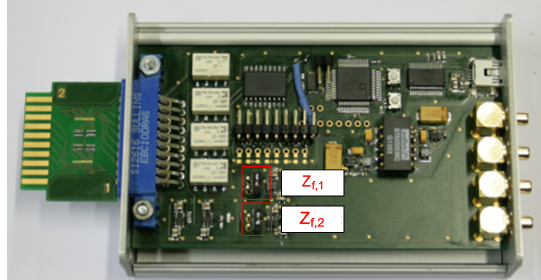
Fig.3: Multiplexer with frontend. At the left side is the receptacle for the adapter PCB with the chip. In the image, a test-chip with fixed resistors is shown. At the right side are the coaxial connectors to the Solartron S-1260 and the USB-connection for the microcontroller. The connectors in the middle of the PCB are for indicator-LED, showing the active electrode pair. A push- switch is implemented for manually advancing the position of the multiplexer. The feedback resistors are inside the red labeled